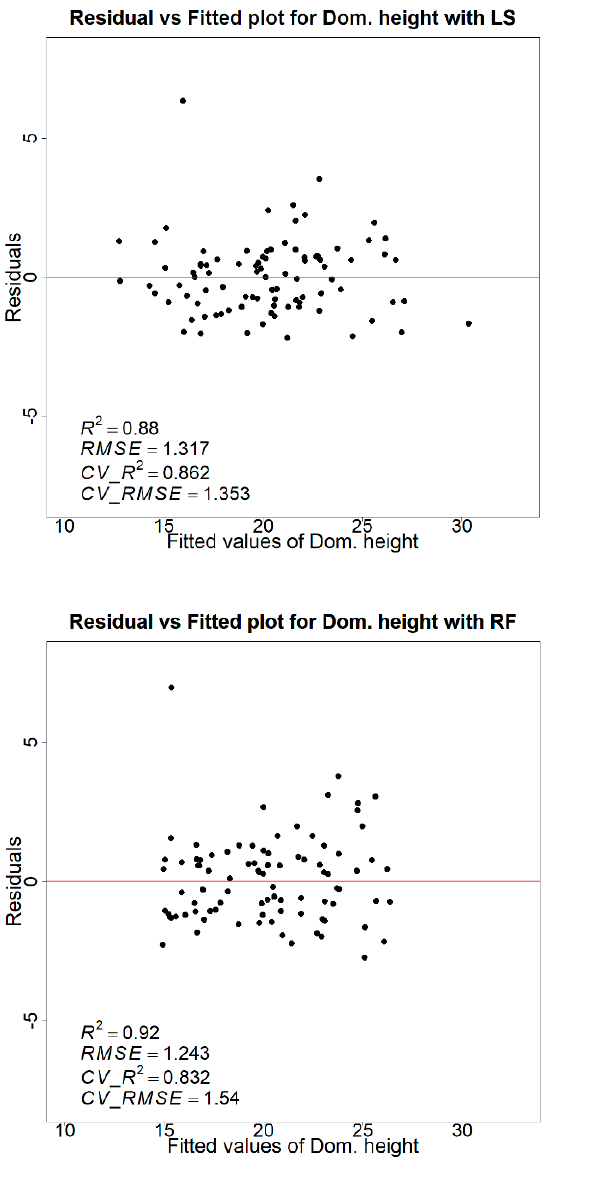
Figure A3. Each panel shows the residual vs. fitted plot for dominant height with LS, ALASSO, RF, and GAMSEL models. R 2 and RMSE are the model accuracy before cross − validation, and CV_R 2 and CV_RMSE show the model accuracy result of nine − fold cross − validation.